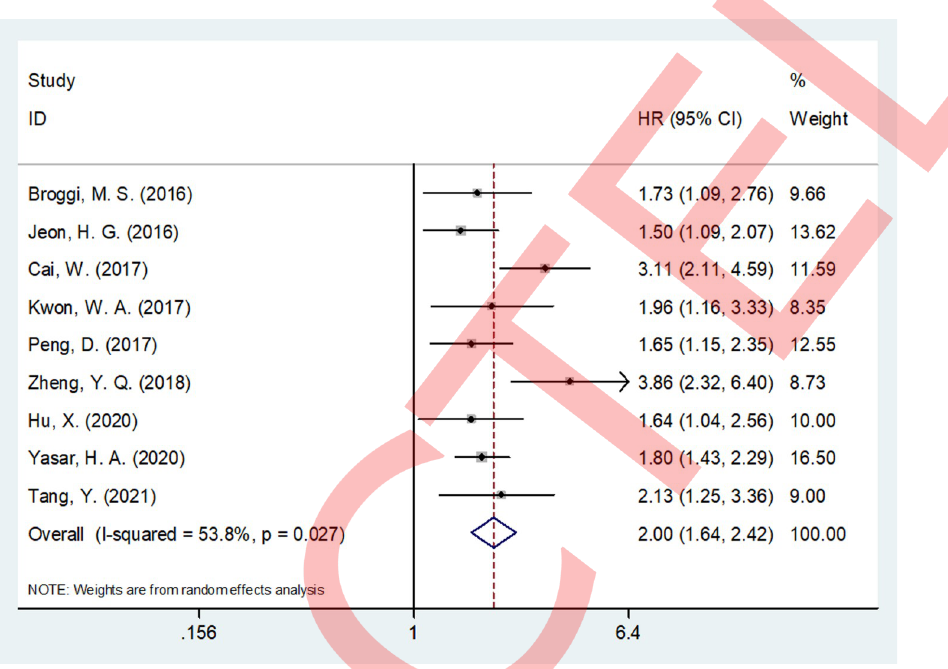
Fig 2. Forest plot indicating the association between PNI and OS in renal cell carcinoma.